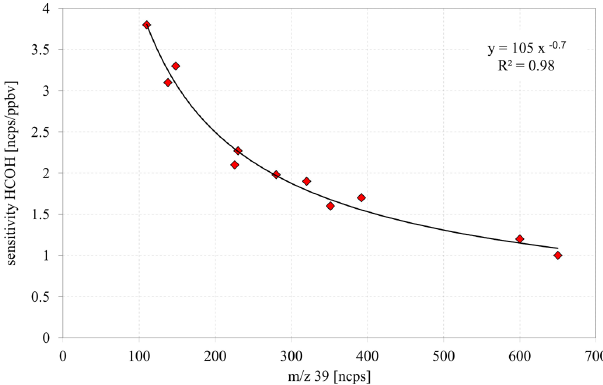
Figure 3. Scatter plot of formaldehyde sensitivities versus H 218 O H 3 O + ( m/z 39) as a reference for the absolute humidity in the drift